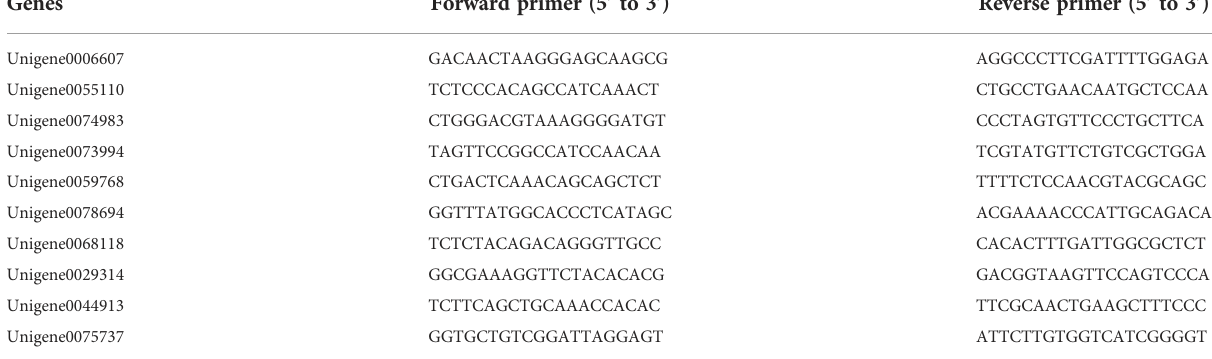
TABLE 1 qRT-PCR Primer information. Genes Forward primer (5 ’ to 3 ’